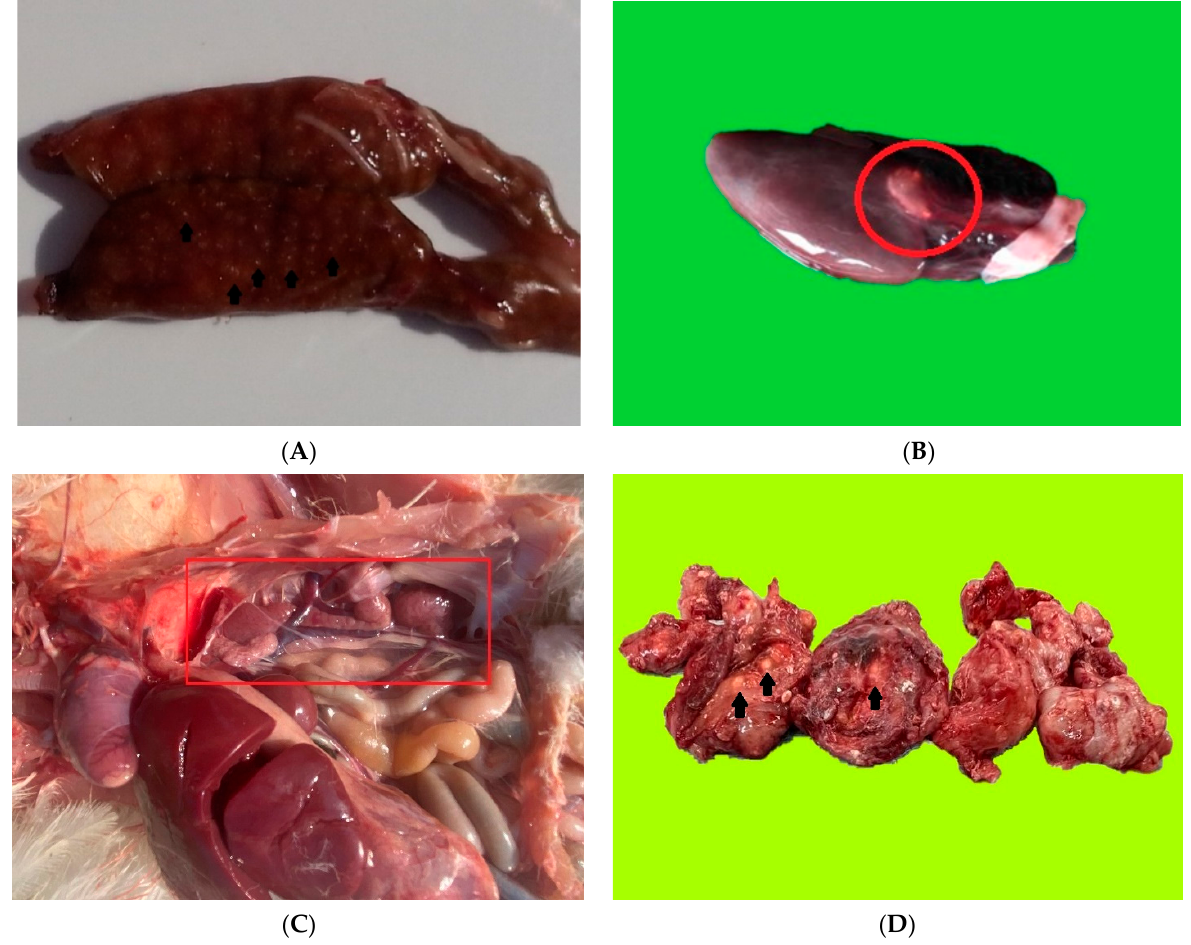
Figure 1. ( A ) Chameleon. White-yellow foci of uric acid within kidney parenchyma. ( B ) Snake. Heart—white chalky deposit (red circle). ( C ) Poultry. Coelomic cavity. Enlarged, pale, granulary- surfaced kidney (red box mark)—degenerative aspect. ( D ) Human. White chalky foci within hand joints.